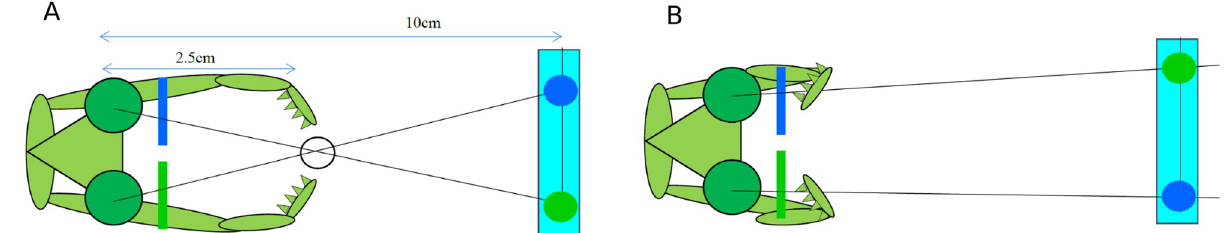
Fig 1. Praying mantis viewing a simulated target in (A) crossed and (B) uncrossed geometry. Each element of the target is displayed on a screen 10 cm away, well outside the catch range. Coloured filters placed over the mantid’s eyes ensure that each eye sees only the intended target. In (A), the target is simulated as being at 2.5 cm, where the lines of sight cross, eliciting a strike. In (B), left and right images are exchanged so the lines of sight diverge. mantids rarely strike at such stimuli [10,